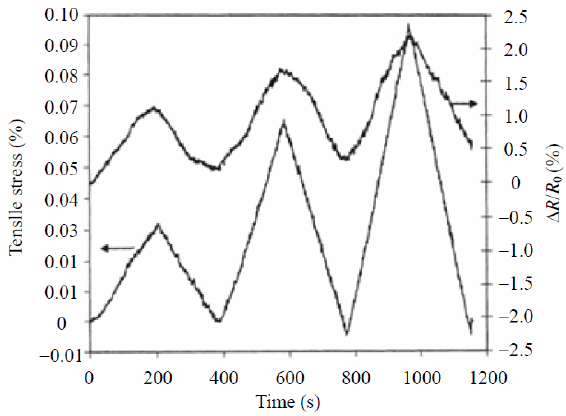
Fig. 8 Variation of changes in resistance during loading and unloading for various stress amplitudes within the linear portion of the stress-strain curve for a cement matrix composite with 2.60 vol.% carbon fibers. Reprinted with permission from [14].